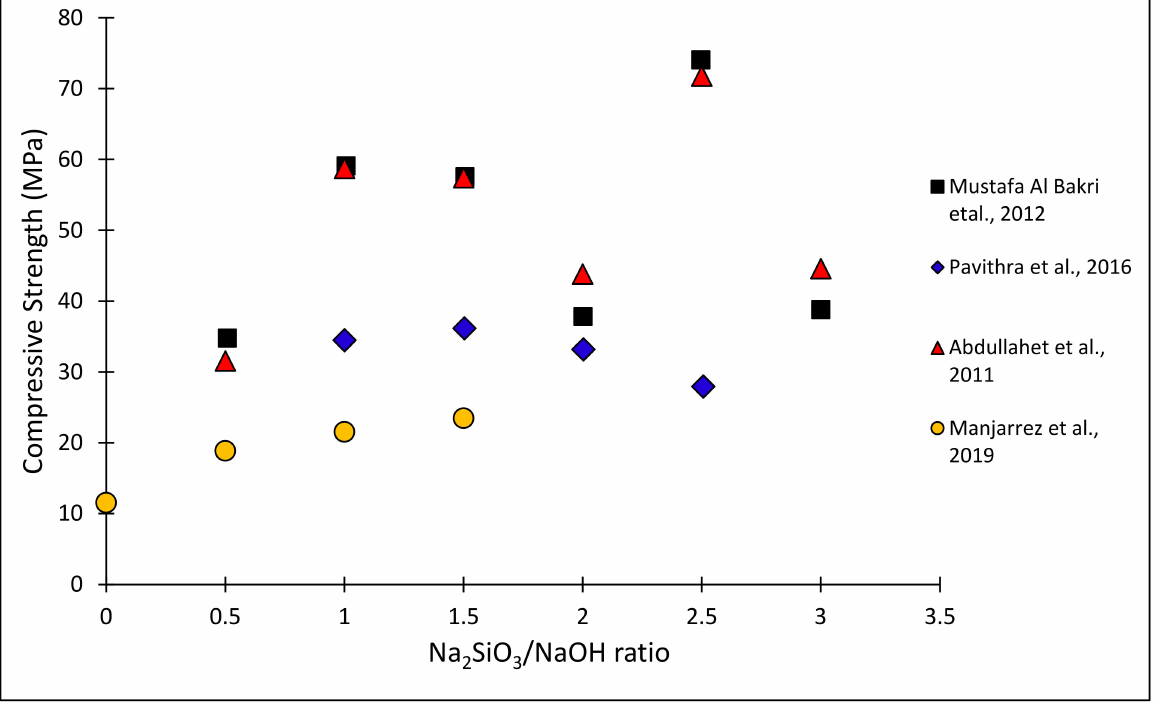
Figure 5. GraphcompilingcompressivestrengthdataversusNa 2 SiO 3